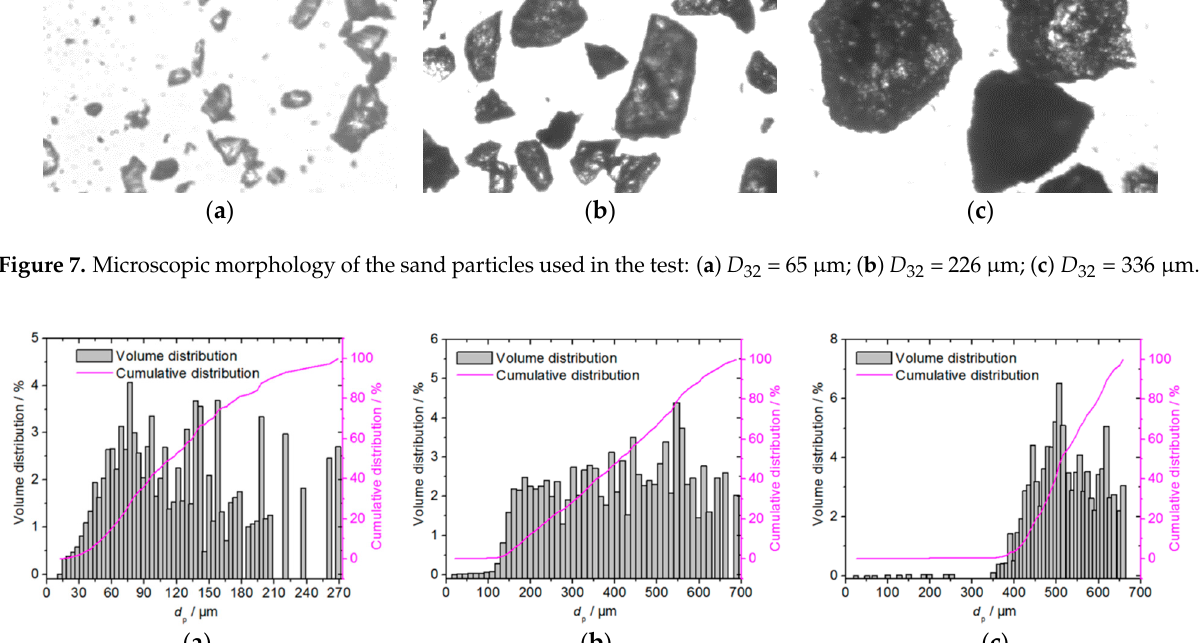
Figure 7. Microscopic morphology of the sand particles used in the test: ( a ) D 32 = 65 μ m; ( b ) D 32 = 226 μ m; ( c ) D 32 = 336 μ m.